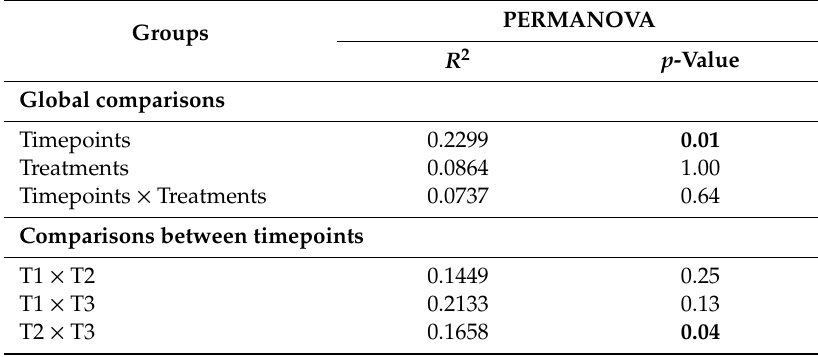
Figure 1. Microbial community composition of Acropora digitifera . Relative abundance of microbial taxa at ( A ) phylum and ( B ) family levels in corals subjected to various light treatments (ambient, warm white, and cold white) for di ff erent durations (T1, January; T2, February; and T3, March). Phyla or families representing < 0.1% of the total community are represented as “Other microbial phyla” and “Other microbial families”, respectively. Table 1. Comparison of Acropora digitifera microbial communities at the amplicon sequence variant (ASV) level between di ff erent light treatments and timepoints. Benjamini-Hochberg-adjusted p -values in bold denote statistical significance at p < 0.05. PERMANOVA: permutational multivariate analysis of